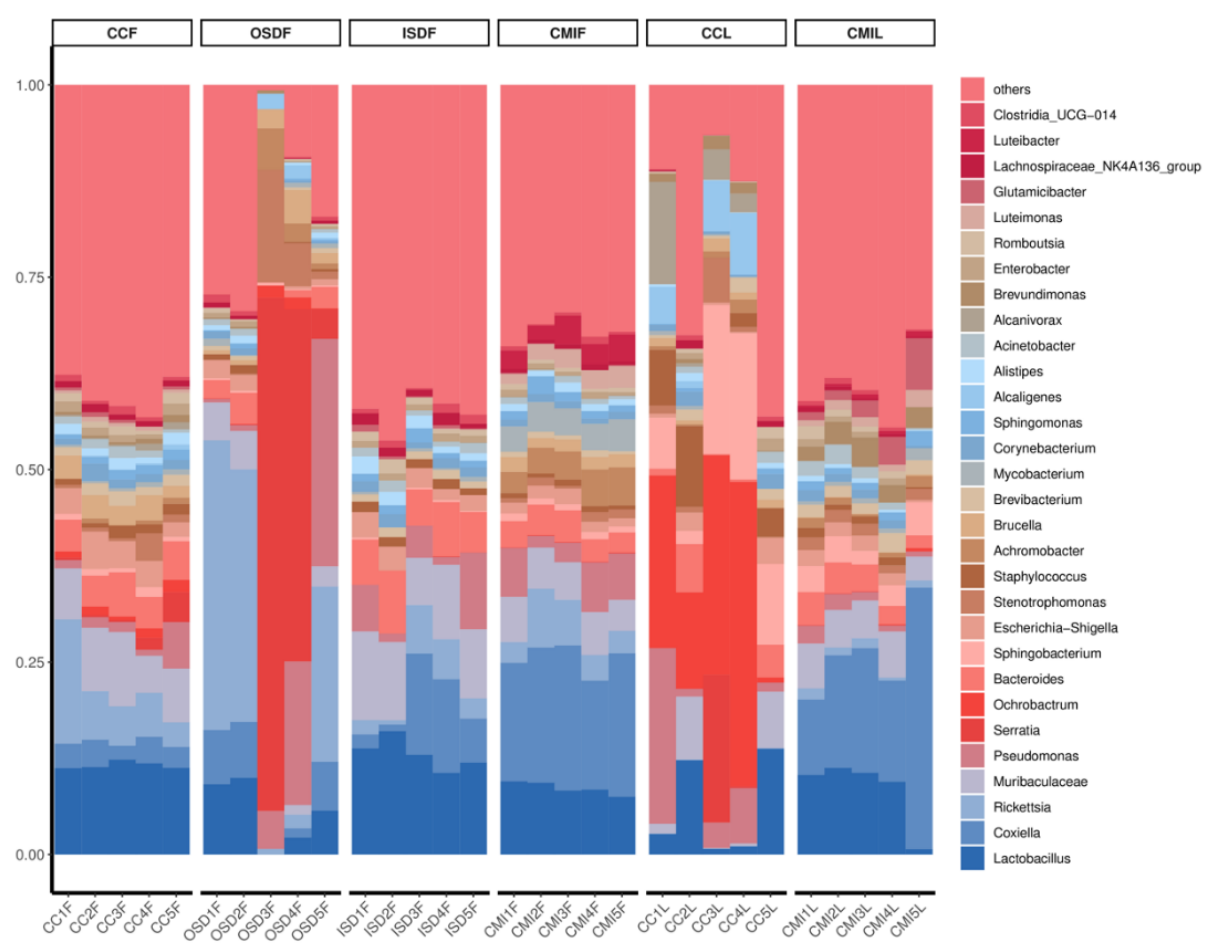
Figure 4. Relative abundances of potential top 30 pathogens at genus level in grouped H. flava and